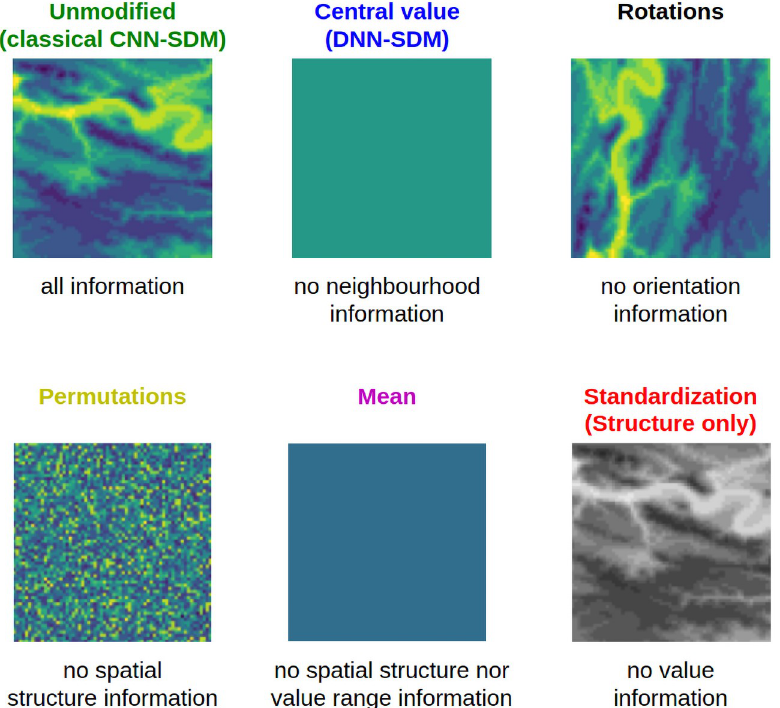
Fig 3. Ablation study transformations. Illustration of the ablation study transformations on one layer of a tensor. Artificial colors from purple (lowest value) to yellow (highest value). The standardization transformation is in shades of gray to illustrate the deprivation of true environmental values. The colors of the names correspond to the colors of the respective curves in the results.